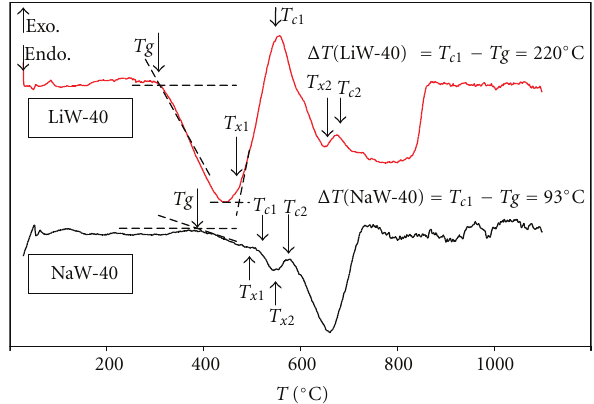
F 1: DTA curves of the AW-40 (A = Li, Na)